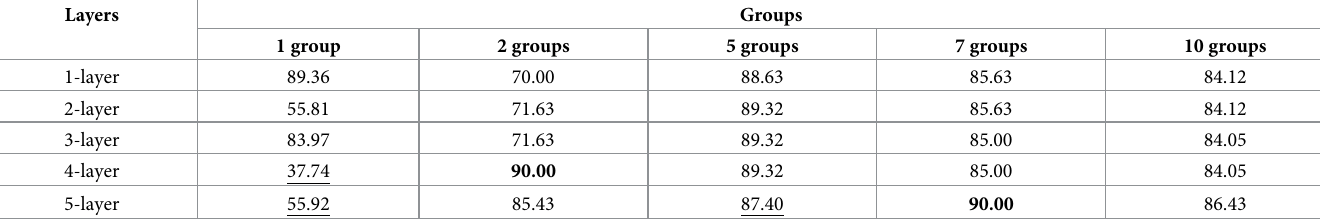
experiment, we also extract clusters into 1 group, 2 groups, 5 groups, 7 groups, and 10 groups as experimental comparisons. To describe the effect of layers, we write the classification accu- racy results in the first five layers. Tables 6–10 show the detailed results. Among them, data with the highest classification accuracy is highlighted in bold. The invalid accuracy data after reaching the cut-off condition is marked in underlined.